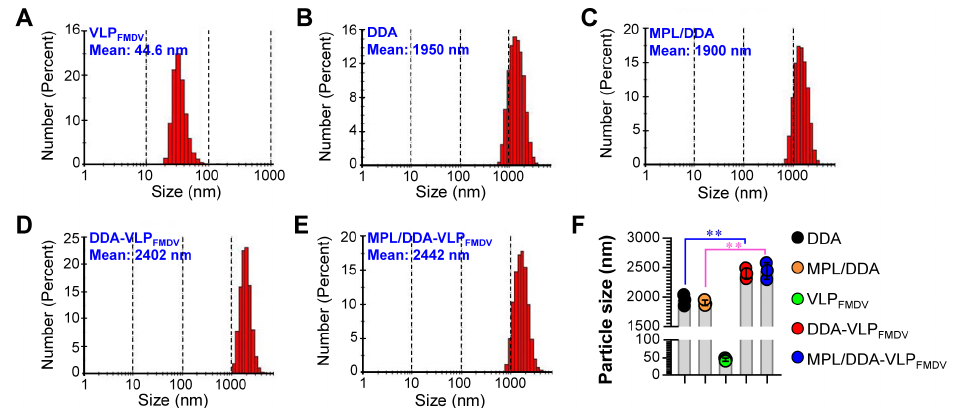
Figure 1. Physical characterization of virus-like particle (VLP) vaccines formulated with dimethyldioctadecylammonium bromide (DDA) or / and monophosphoryl lipid A (MPL). Particle size distributions of VLP FMDV ( A ), DDA ( B ), MPL / DDA ( C ), DDA-VLP FMDV ( D ), and MPL / DDA-VLP FMDV ( E ) were measured by DLS analysis. VLP FMDV : recombinant food-and-mouth disease VLP vaccine; MPL / DDA: MPL and DDA formulation; DDA-VLP FMDV : VLP FMDV formulated with DDA; MPL / DDA-VLP FMDV : VLP FMDV formulated with DDA and MPL. ( F ) Bar graph is expressed as the mean ± SD of 3 samples per group. ** p < 0.01.